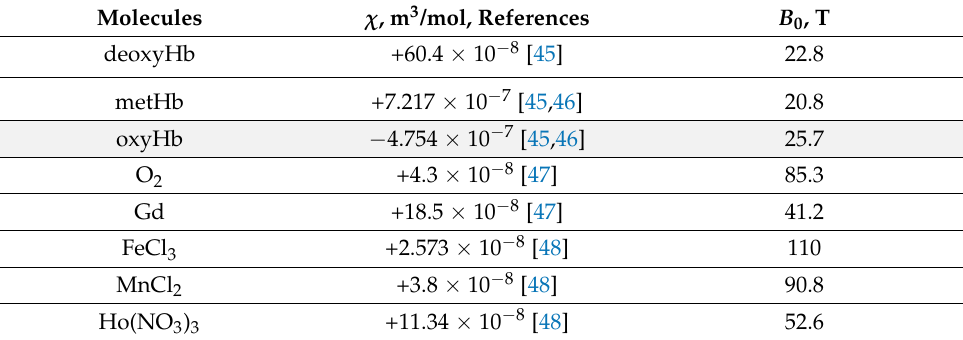
Table 1. Values of the magnetic field induction (in teslas), corresponding to the onsets of the MF’s effects on diffusion, as calculated from Equation (7) for different paramagnetic and diamagnetic molecules and β 0 = 0.05. Gray colors indicate diamagnetic